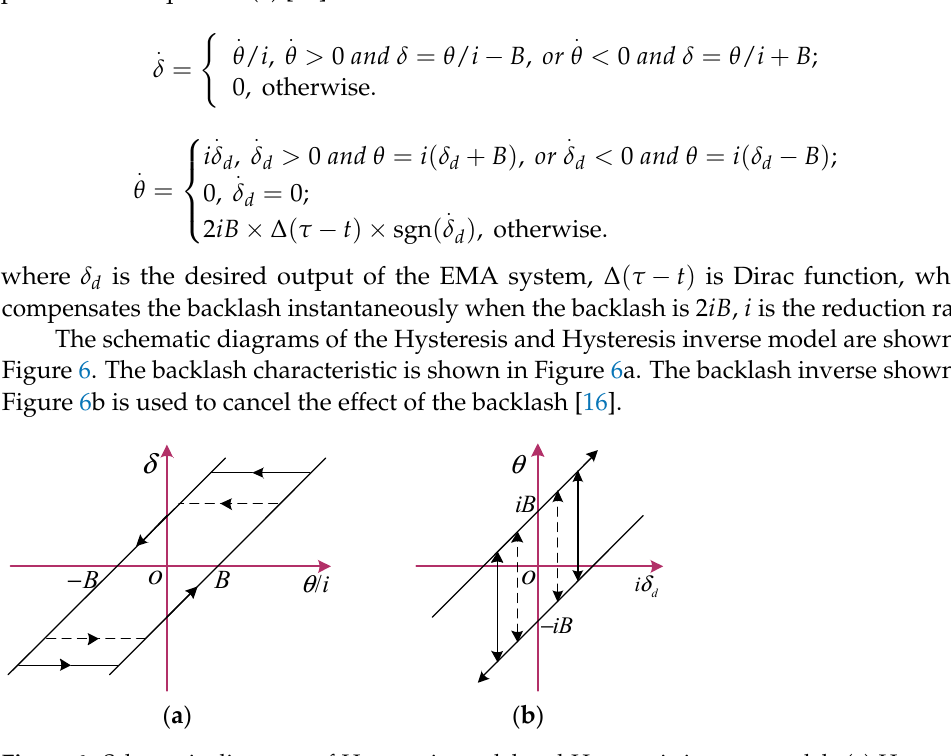
Figure 6. Schematic diagrams of Hysteresis model and Hysteresis inverse model. ( a ) Hysteresis model; ( b ) Hysteresis inverse model.